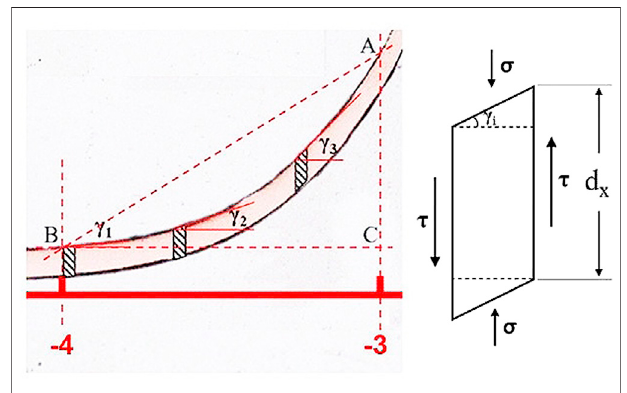
FIGURE 4 | Acceleration fl ow stage and approximate deformation